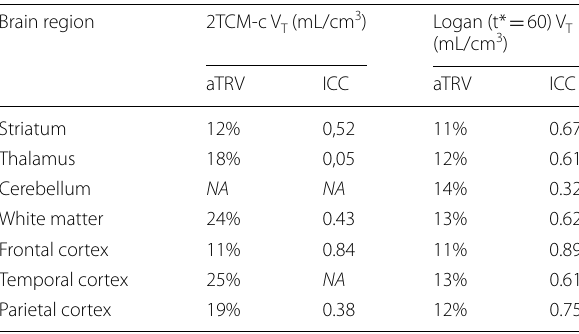
Table 2 Summary of aTRV and ICC values for V 2TCM-c and